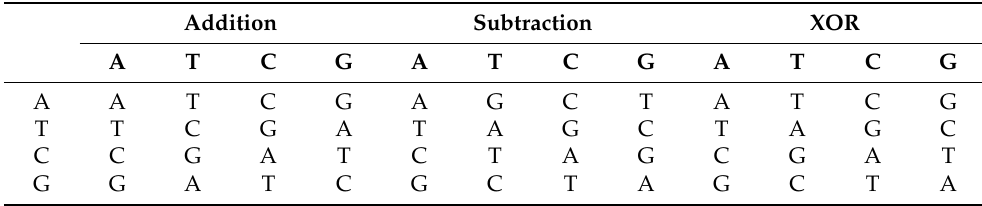
Table 2. The rules of DNA